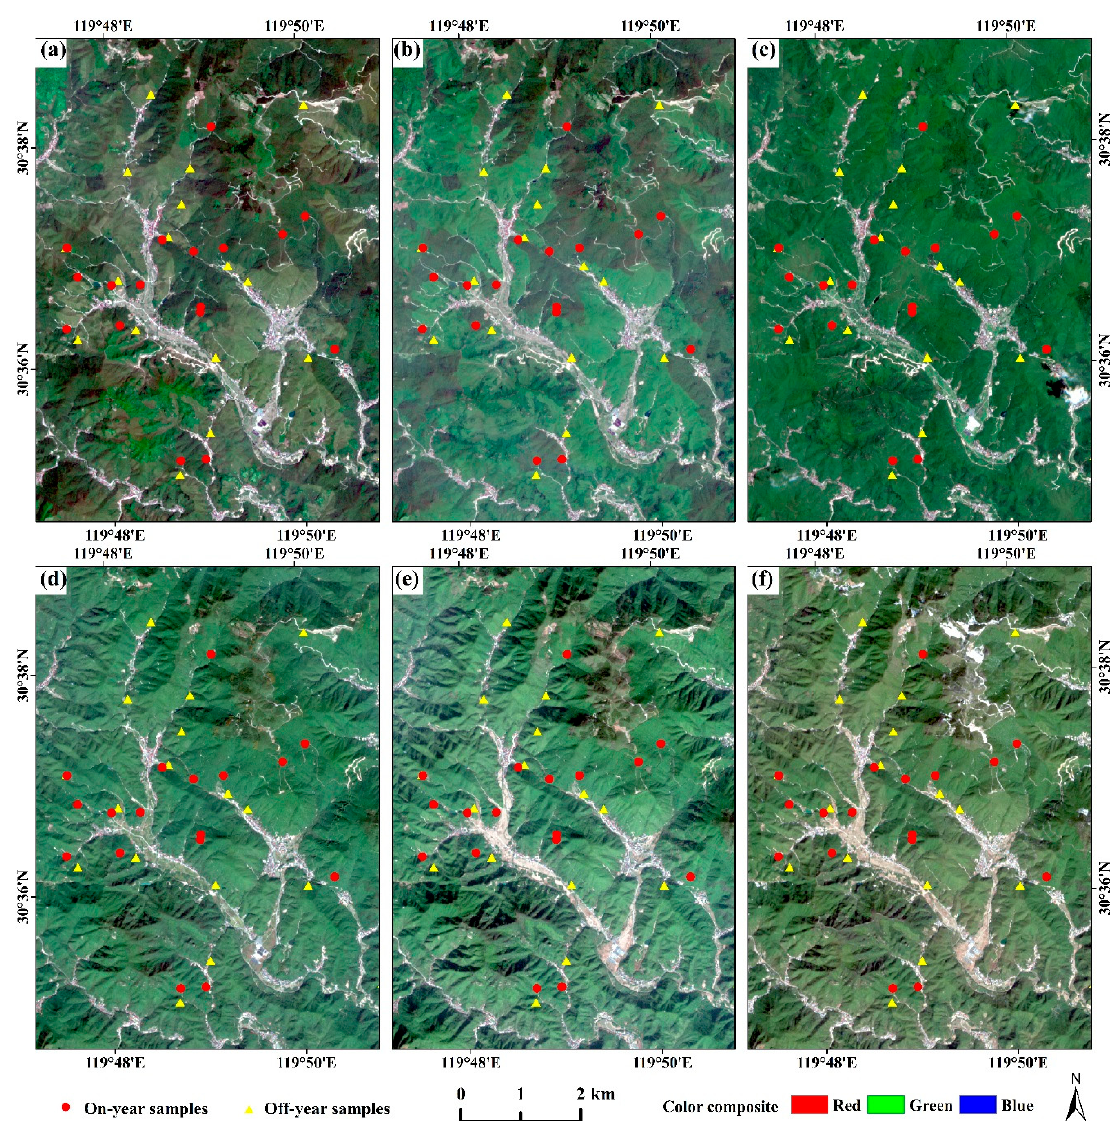
Figure 2. Comparison of on-year and off-year bamboo forests in true color composites using red, green, and blue spectral bands of the Sentinel-2 data at different dates. ( a ) 19 April 2018; ( b ) 4 May 2018; ( c ) 18 July 2018; ( d ) 31 October 2017; ( e ) 25 December 2017; ( f ) 23 February 2018.